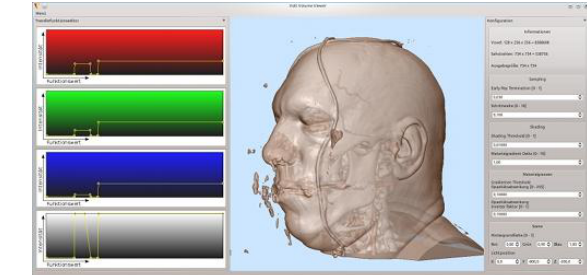
Figure 5. VOLT: application window and the VisMale